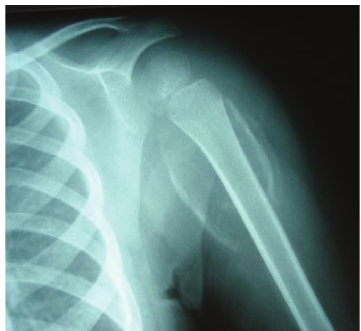
Figure 2: Anterior-posterior radiograph of the left shoulder showing osteopenia and detachment of the periosteum of the humeri.